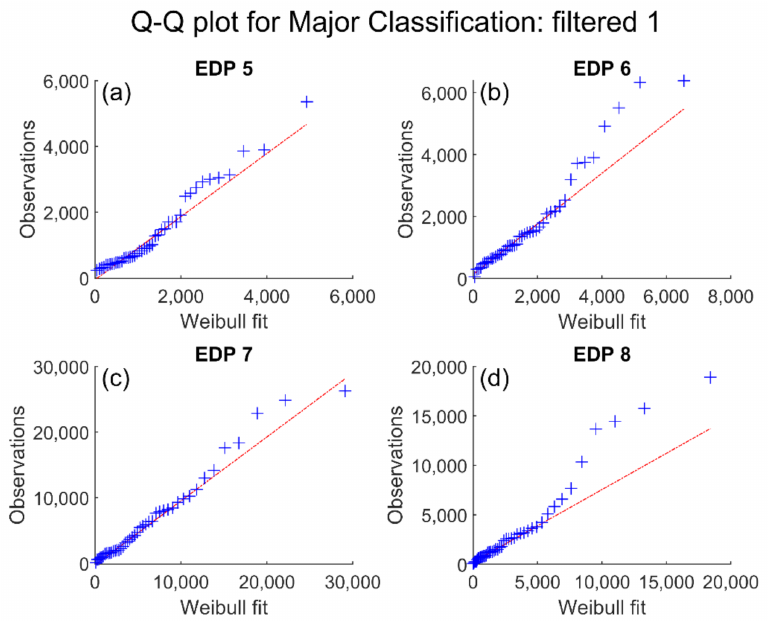
Figure 9. Weibull distribution quantile plots removing maximum observation corresponding to Major classification with a single datapoint removed. Only EDP cases 5 to 8 are shown for clarity. ( a ) EDP 5—Shear; ( b ) EDP 6—Moment; ( c ) EDP 7—Simplified Mass-moment of Inertia; ( d ) EDP 8—Mass-moment of Inertia.